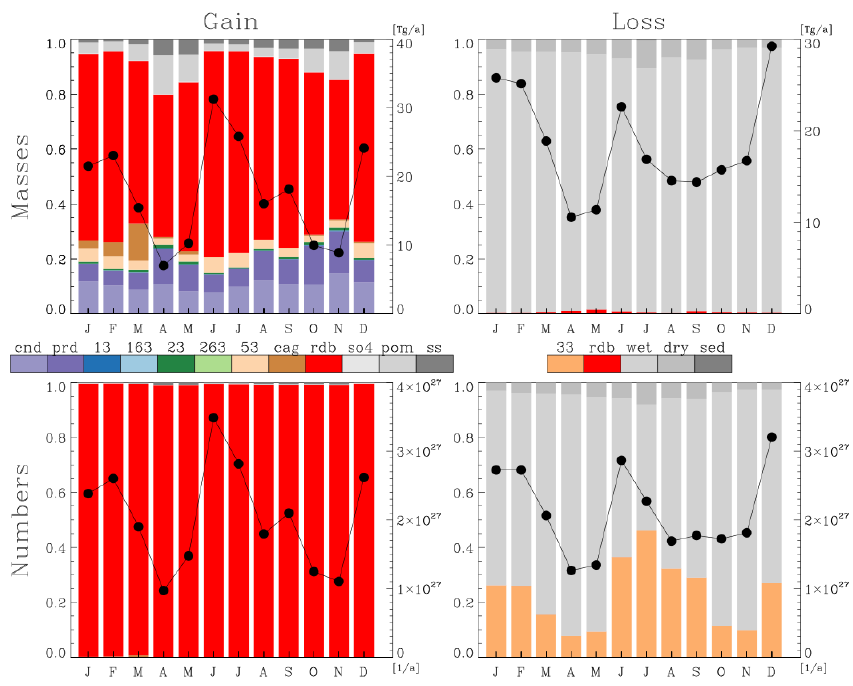
Figure 17. Seasonal cycle of regional tendencies of the hydrophilic accumulation mode over the Savanna (see Fig. 1). The colored bars show fractional tendencies (left axis) for the processes defined in Table 2. The solid line (right axis) shows the total tendency.